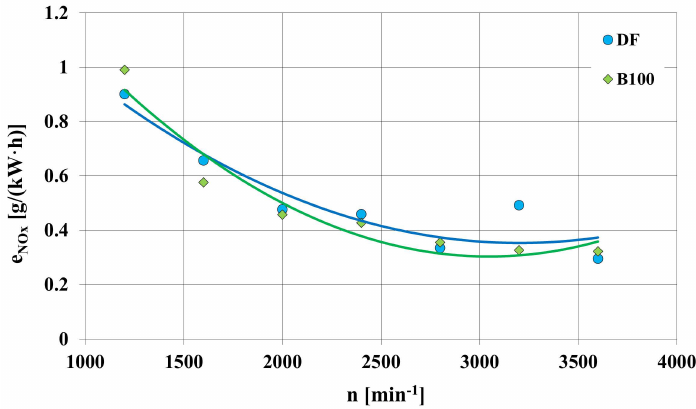
Figure 7. External speed characteristics of the specific brake emission of nitrogen oxides-e NOx in the rotation speed domain-n for the engine powered with fuels DF diesel or